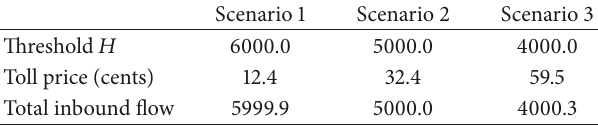
Table 3: Three scenarios of threshold and the optimal toll